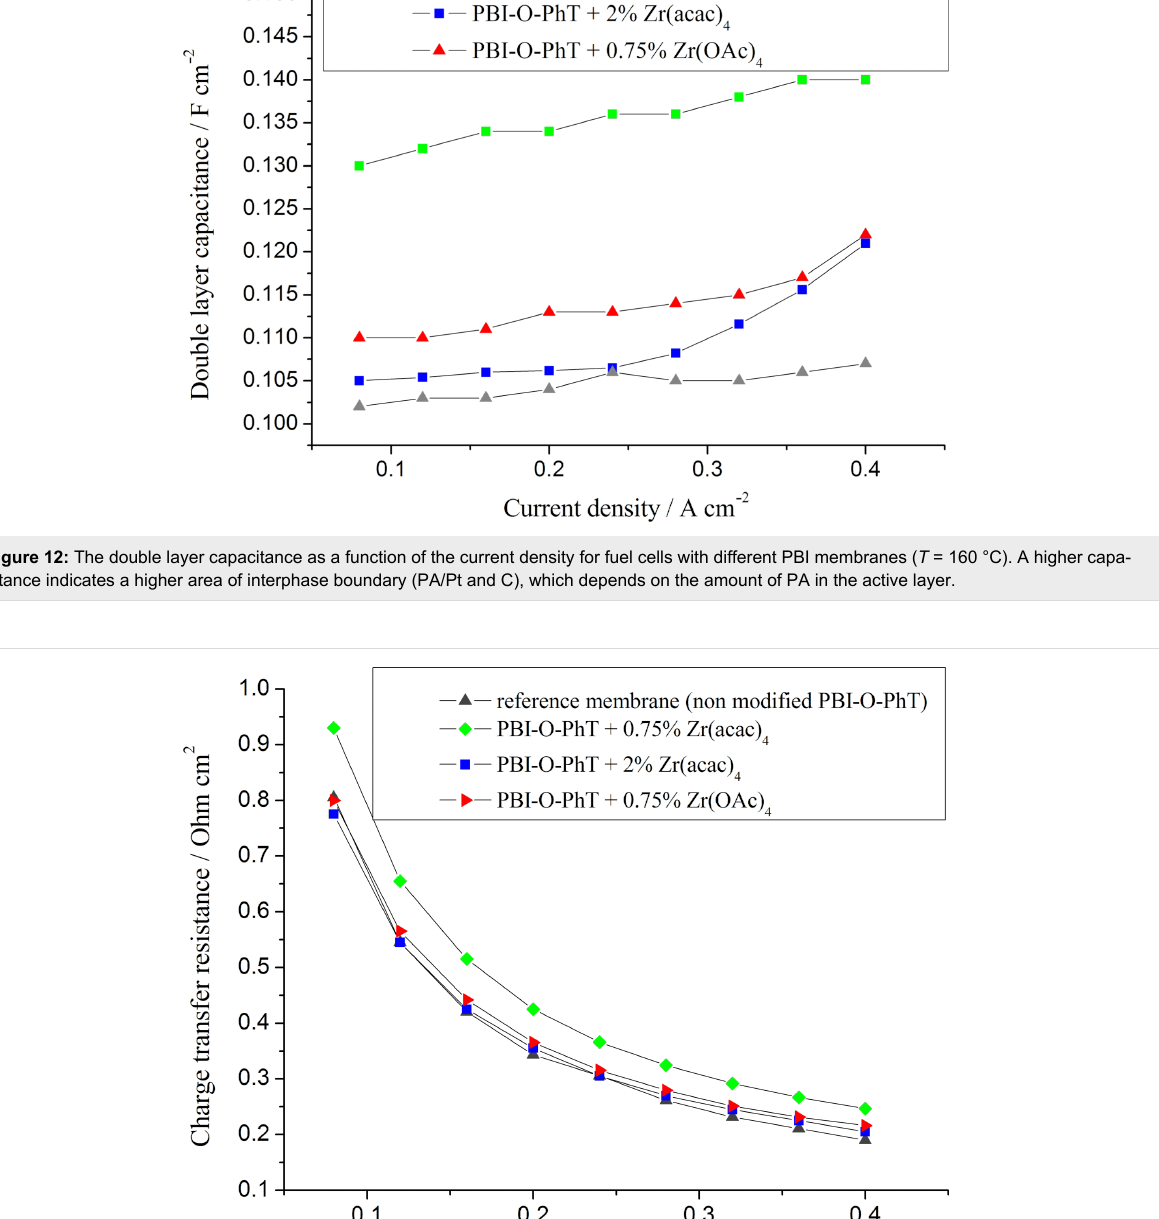
with 0.75 wt % Zr(acac) 4 , which release large amounts of acid in the AL. The PBI-O-PhT films with 0.75 wt % Zr(OAc) 4 release lower amounts of PA, and so the polarization resistance for FC based on these membranes is lower. Yet the lowest po- larization resistance is observed for FC with the pristine refer-